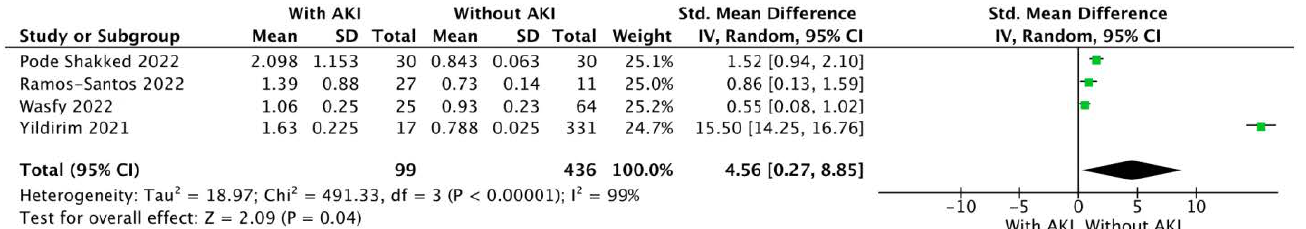
sults. Legend: CI: confidence interval; SD: standard deviation.